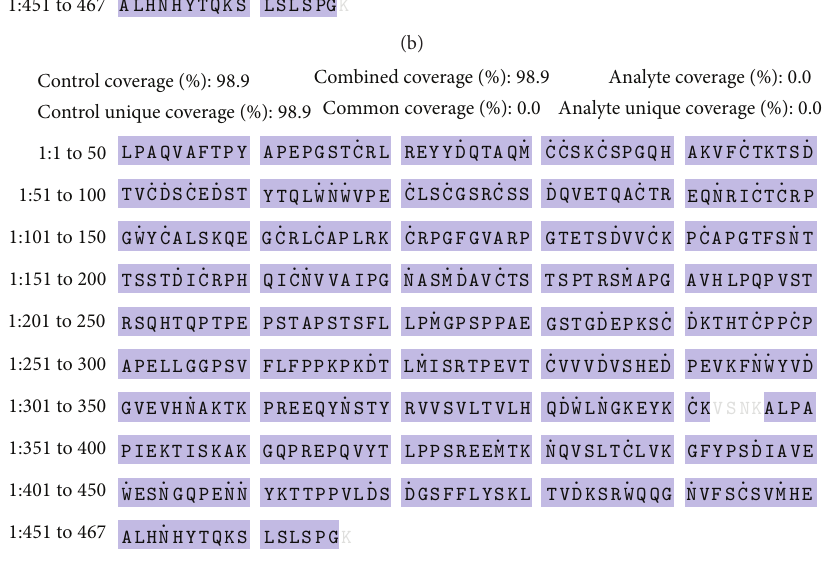
Figure 1: Confirmation of the primary structure by peptide mapping of (a) Infinitam (upper chromatogram in green) and the reference product (lower chromatogram in blue), and sequence coverages of (b) Infinitam and (c) the reference product with respect to the